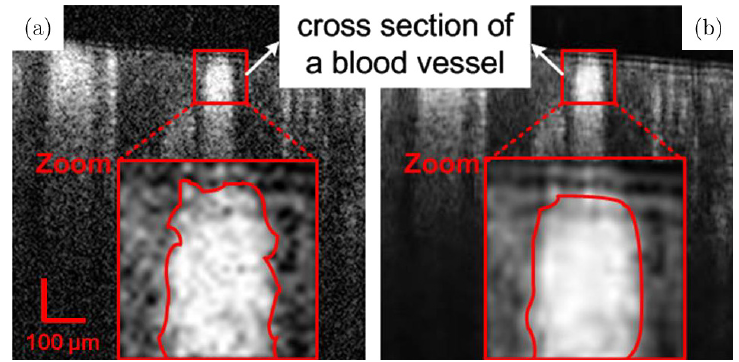
Fig. 7. 2D OCT images of blood vessels (a) before and (b) after denoising by